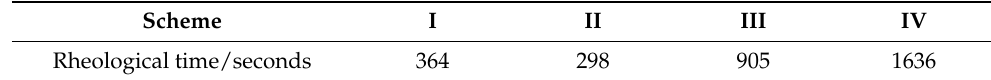
Table 7. Rheological time of four